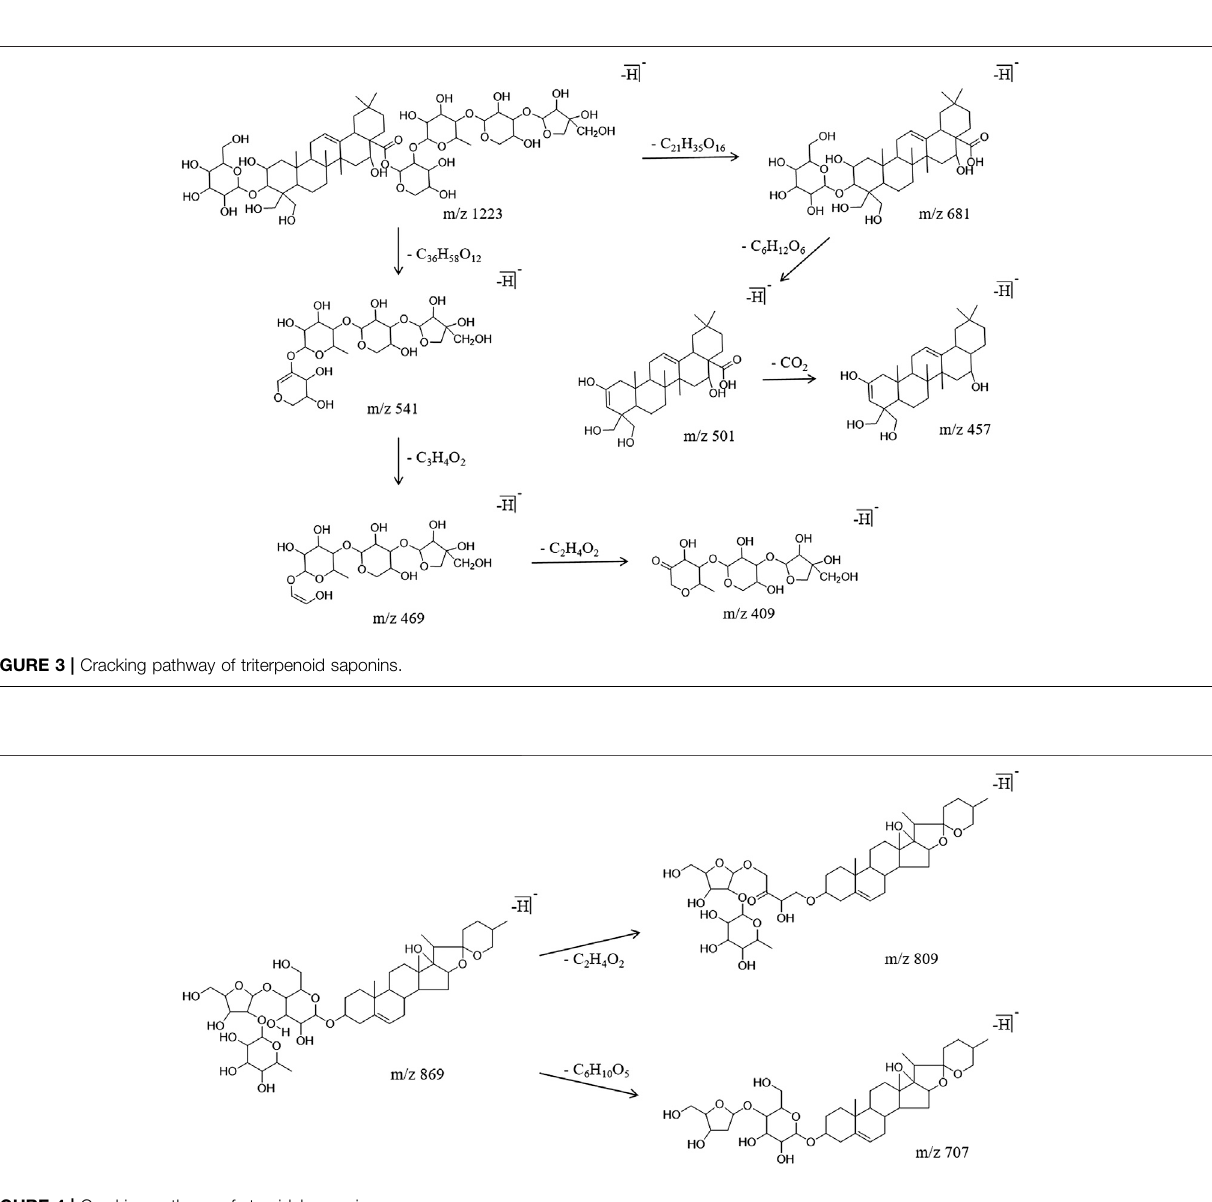
FIGURE 4 | Cracking pathway of steroidal saponins.